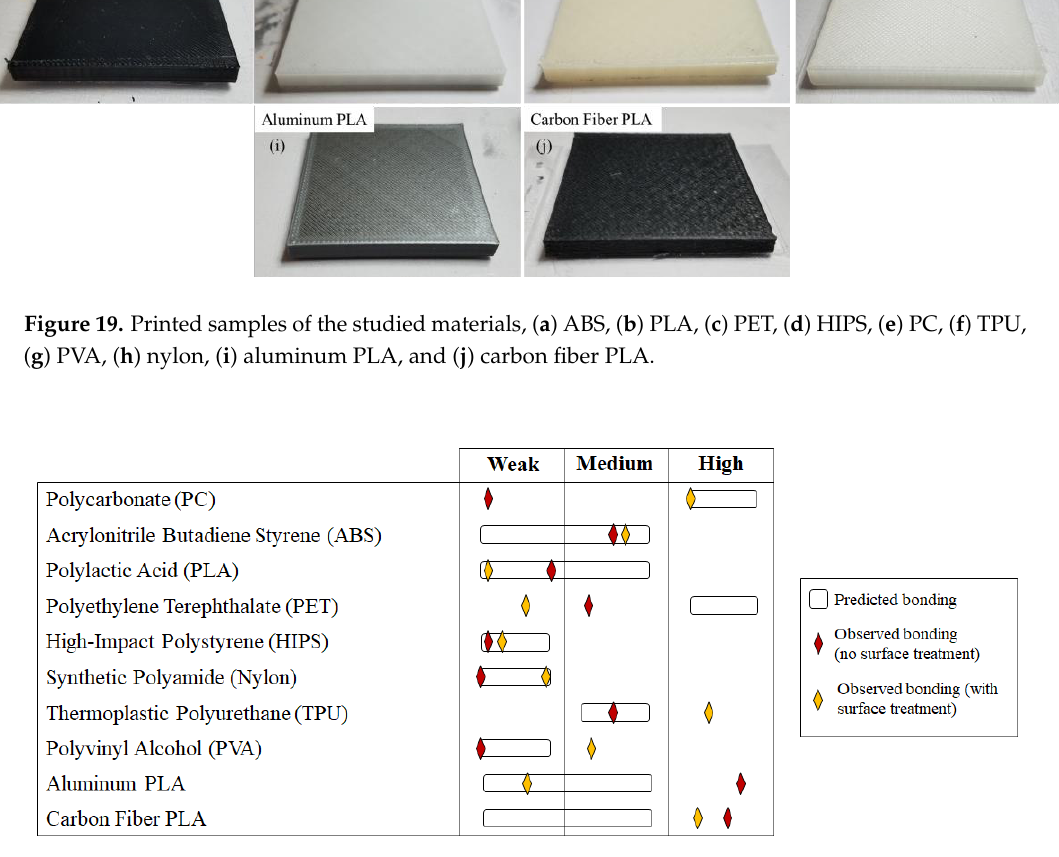
Figure 21. Comparison of magnitude and consistency of normal and bend breaking force, where ( a ) shows the comparison for the normal force and ( b ) the bending force cases. 5.3. Preliminary Nozzle Deposition Heat Effects Study Based on the results of the experiments described and discussed in Sections 5.1 and 5.2, some questions arise about the potential bonding mechanism of the materials to the PC bed. Clearly, some of the materials did not perform as well as expected and this was likely due to the failure of the interface between the materials and the PC to reach a high enough temperature for chemical bonding to be initiated. To explore this further, a simple experiment was designed and performed to test the interface temperature between the PLA and the PC bed; this preliminary experiment clearly does not provide a complete and definitive answer for all the materials, but it does yield some insight into the bonding mechanism that should be discussed in the present study. This will be explored in more depth in future studies on this topic. To test the interface temperature between the extruded material and the PC print bed, a test article was built consisting of a 2.36 mm PC sheet clamped to the heated aluminum print bed; a K-type thermocouple was imbedded in the PC layer in such a way that the thermocouple tip would be in direct contact with both the bed and the part during printing. Care was taken to cut away the absolute minimum amount of material possible for the thermocouple body to be level with the surface, while also taking care that the bead did not directly contact the aluminum bed to avoid shorting it out; the configuration is shown in Figure 22.